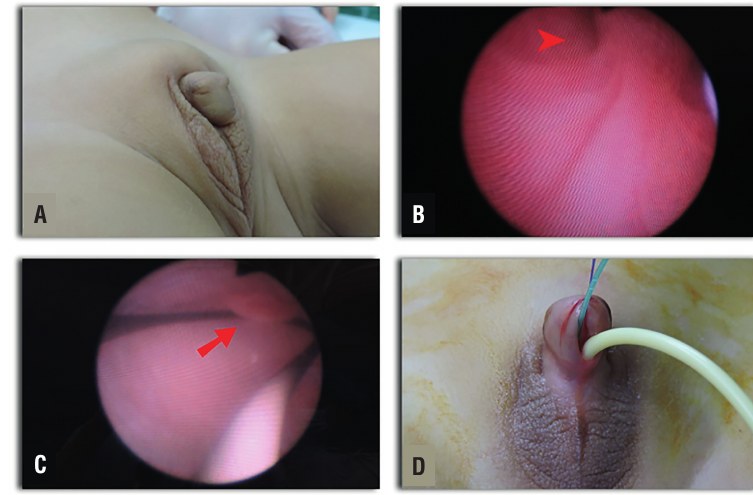
Figure 1 - Patient 1, 24 months old. A) Virilized External Genitalia, Prader V. B) Well-defined (male-like) external sphincter with a verumontanum appearance distal to the vaginal confluence (Arrow head) C) Vagina and Cervix (Arrow) D) A 3 fr Fogarty catheter in the bladder and a 6 fr Foley catheter in the vagina both going through the urogenital sinus